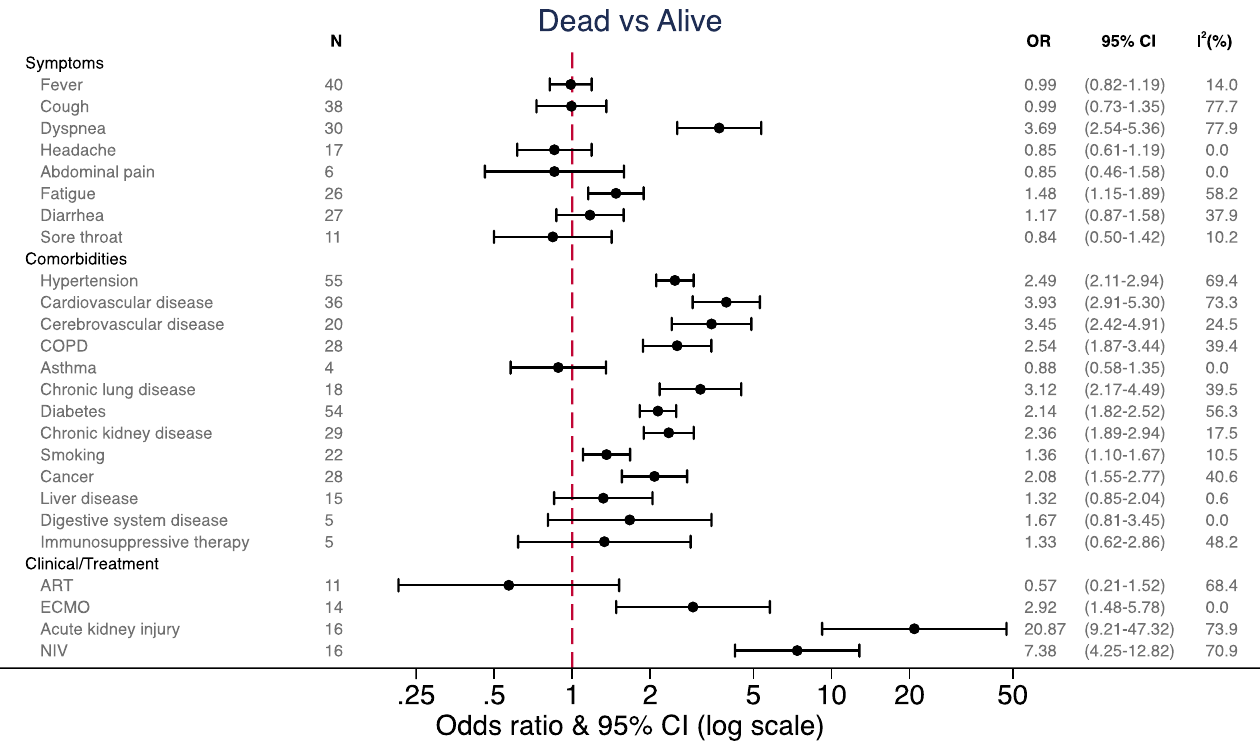
Fig 4. Pooled odds ratios among mortality vs. survived groups. OR = odds ratio, CI = confidence interval, COPD = chronic obstructive pulmonary disease, ART = anti-retroviral treatment, ECMO = extracorporeal membrane oxygenation, NIV = non-invasive ventilation.